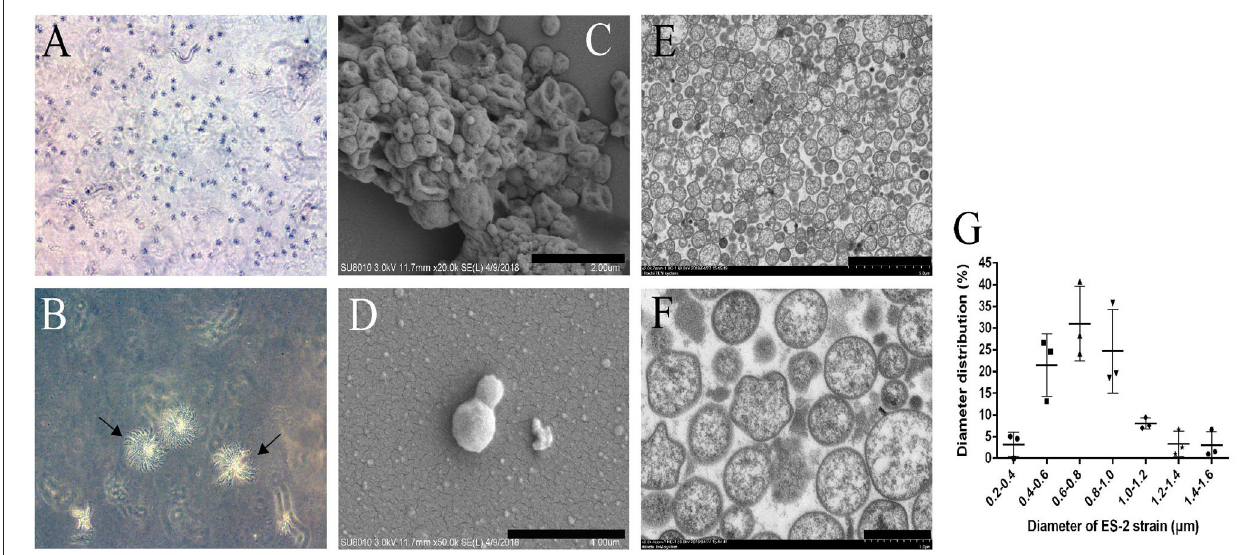
FIGURE 2 | Colony of M. hyopneumoniae strain ES-2 on modified Friis solid media and the ES-2 cell morphology viewed under the electron microscope. A, B The colony of ES-2 strain were viewed by the inverted microscope, (A) 5 and (B) 10 . (C,D) The morphology of strain ES-2 was viewed by scanning electron × × microscope. (C) Bars 2.0 µ m, (D) Bars 1.0 µ m. (E,F) The cytoplasmic structure of strain ES-2 was viewed by transmission electron microscope. (E) Bars = = 5.0 µ m, (F) Bars